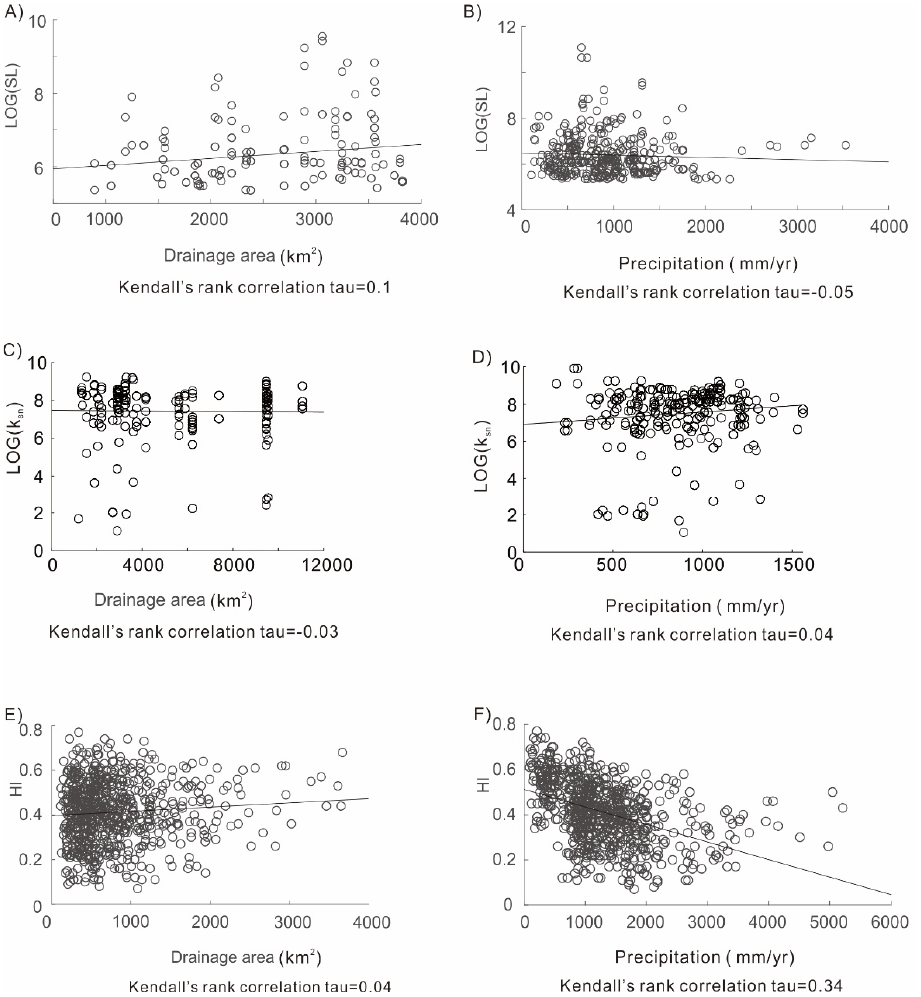
Figure 9. ( A ) Kendall’s rank correlation shows SL values slightly increase with drainage basin area; ( B ) Kendall’s rank correlation shows near zero relationship between SL and precipitation; ( C ) Ken- dall’s rank correlation shows near zero relationship between k sn and drainage basin area; ( D ) Ken- dall’s rank correlation shows k sn values slightly increase with precipitation. ( E ) Kendall’s rank cor- relation shows HI values slightly increase with drainage basin area; ( F ) Kendall’s rank correlation shows HI values are significantly influenced by precipitation. Mean precipitation derived from TRMM data (1997–2006). The maximum rainfall was blocked by the high topography of the Tibetan Plateau and occurred mainly in the west of the Nujiang fault and the southeast of the Red River fault.